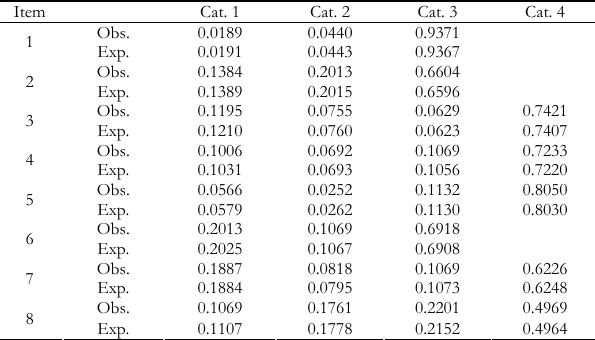
Observed and expected response frequencies according to the GRM, 2nd test Item